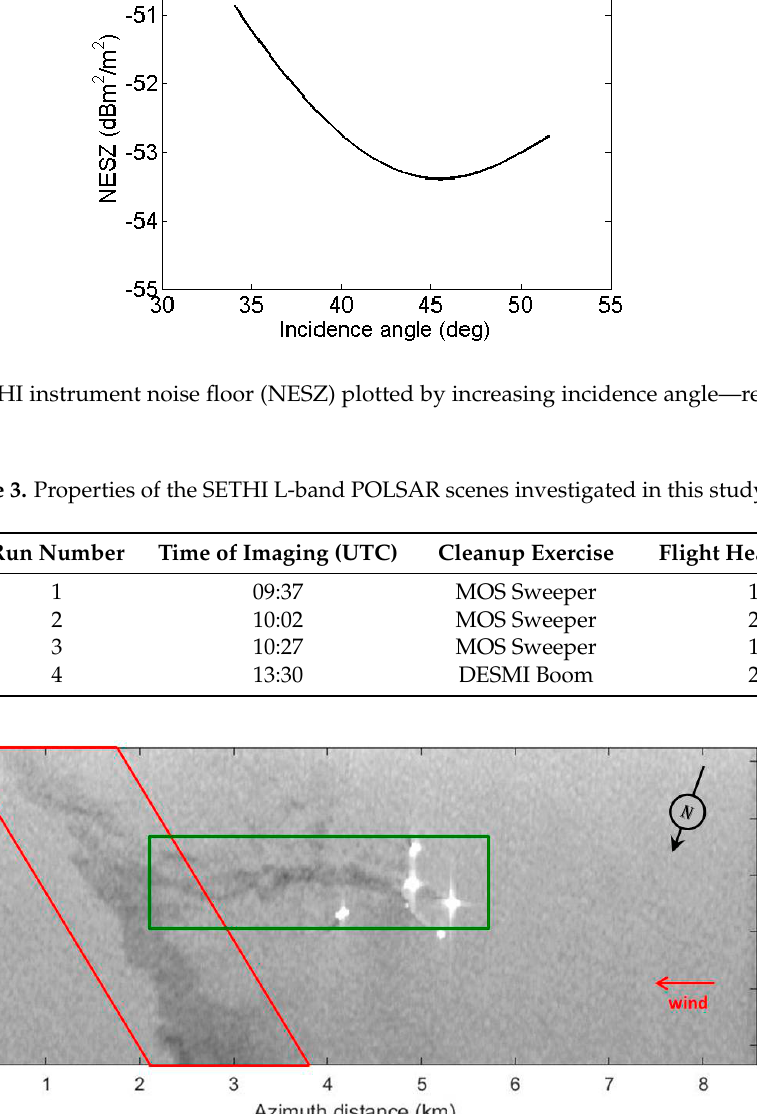
Figure 6. SETHI L-band SAR data, VV-polarization, collected at 09:37 UTC (run 1—upper left panel), 10:02 UTC (run 2—upper right panel), 10:27 UTC (run 3—lower left panel) and 13:30 UTC (run 4—lower right panel)—multi-look 21 × 21—ground geometry.